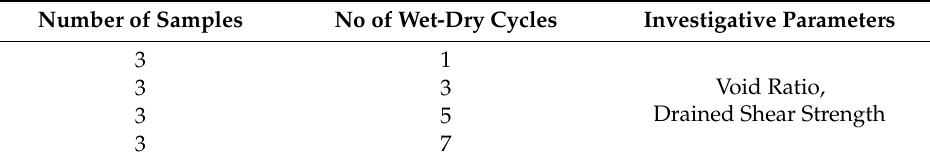
Table 2. Laboratory study of the effect of the wet-dry cycle on Yazoo clay.